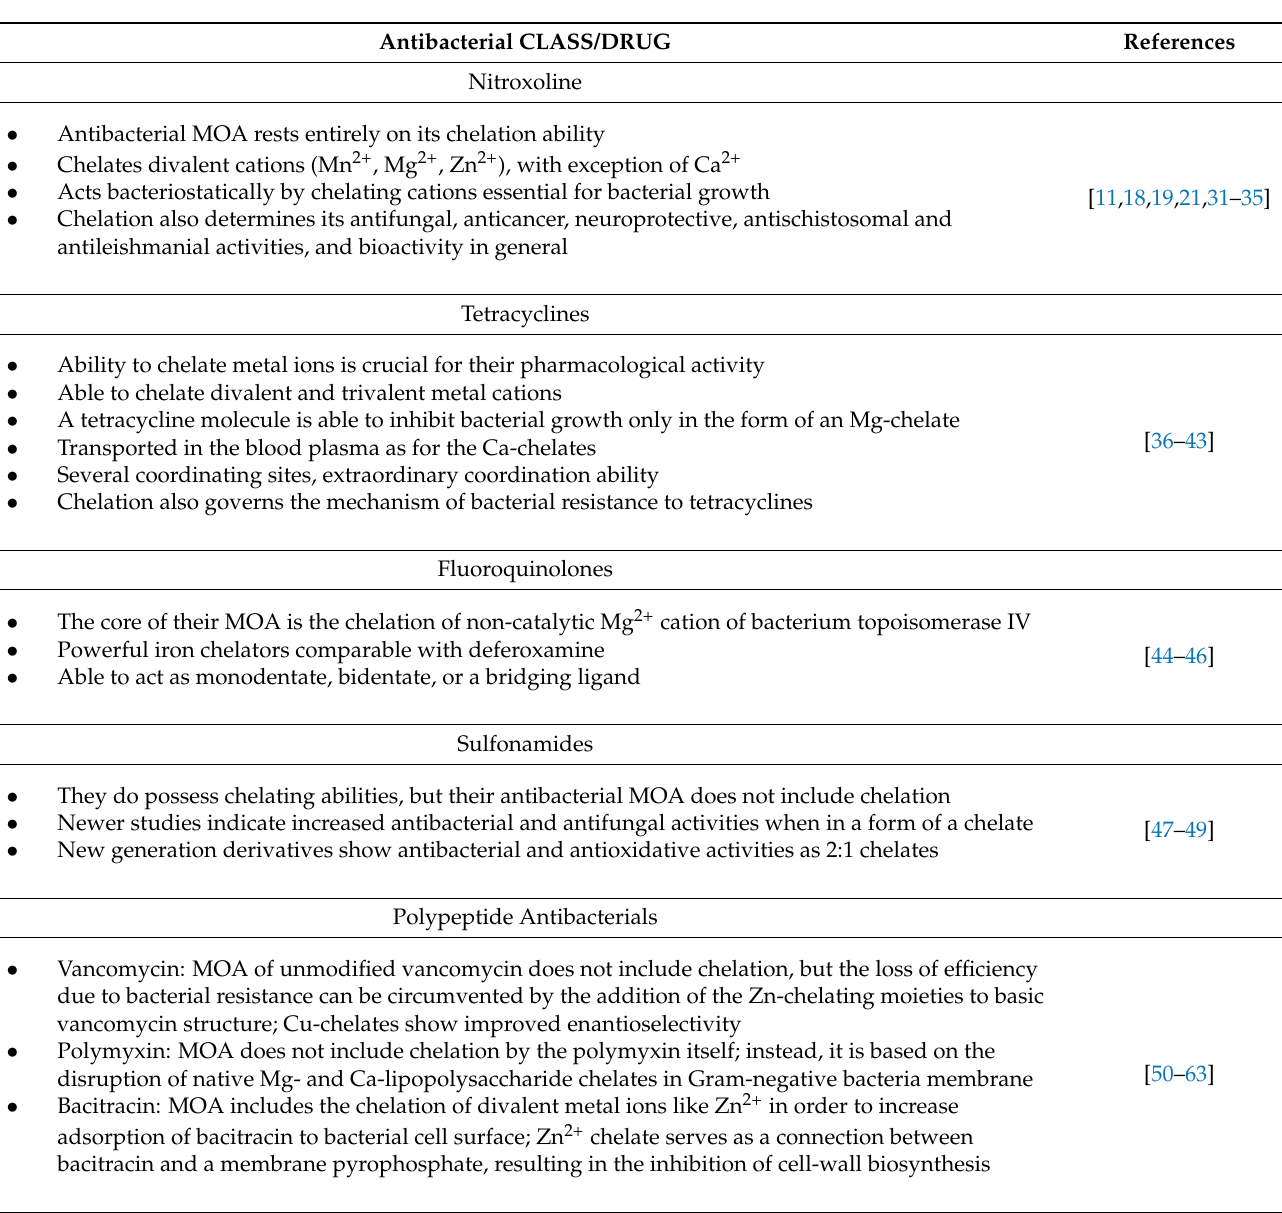
Table 1. An overview of the chelation relevance in modes of actions (MOAs) of different antibacterial drug